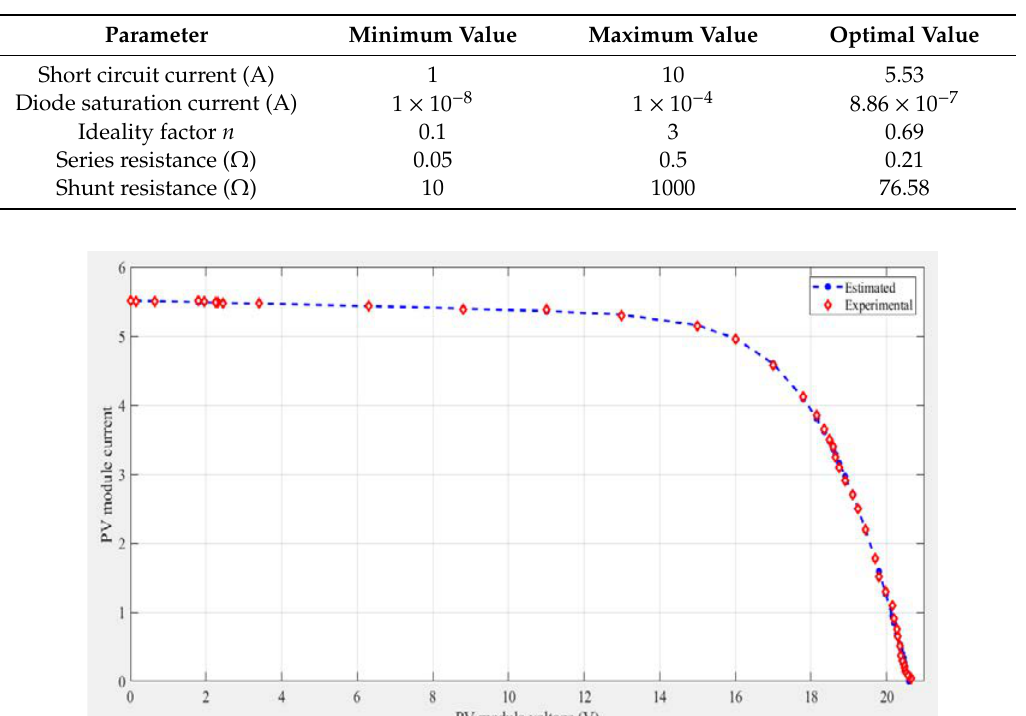
Figure 15. Comparison between the experimental and estimated I - V data of PV panel which was coated with SiO 2 nanomaterial.